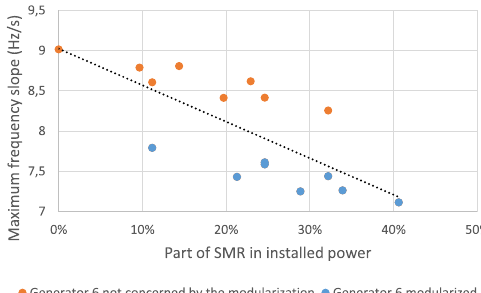
Fig. 15. Evolution of maximum frequency slope against the part of modularized installed capacity in the